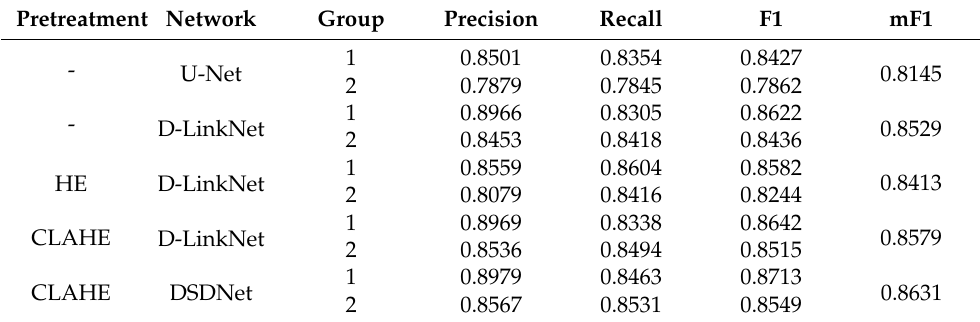
Table 1. Accuracy of different experimental